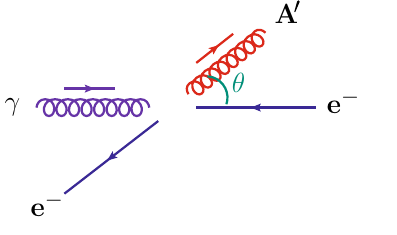
Fig. 2 The production of the dark photon A (cid:2) in the γ e − collision